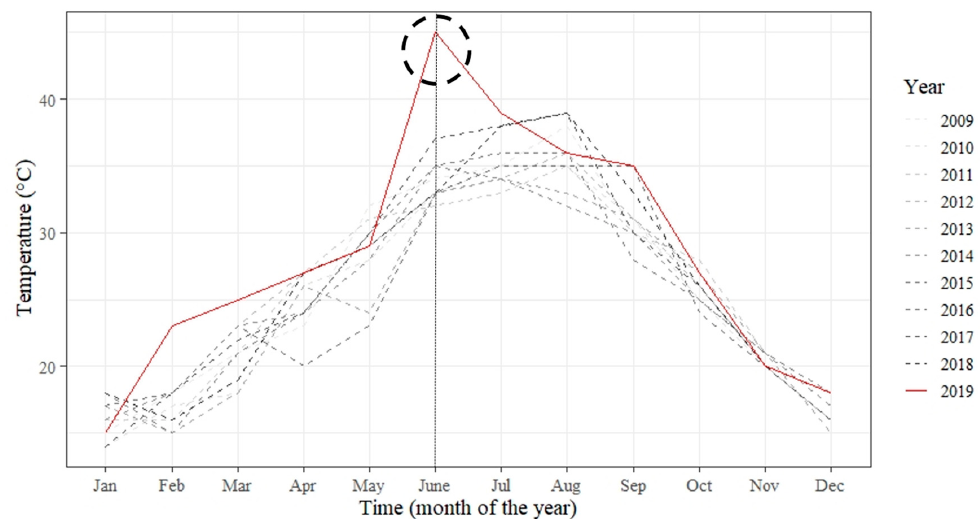
Figure 2. Maximum monthly temperatures recorded from 2009 to 2019 over the Languedoc-Roussillon region, France, highlighting a peak corresponding to the extreme weather event that occurred in June 2019. The vertical black dashed line highlights the month of the heatwave. Source: Historique Météo-France.